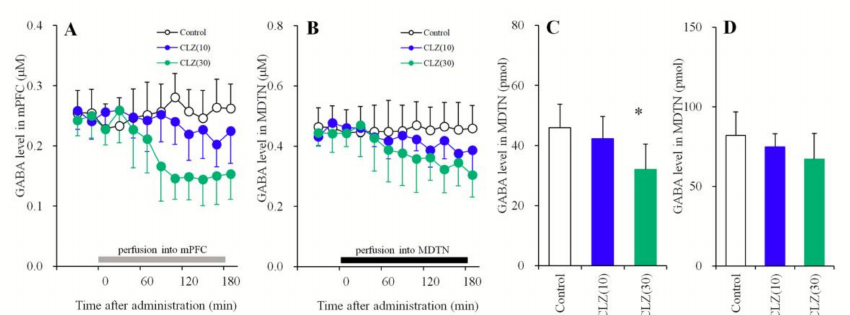
Figure 4. Concentration-dependent effects of the local administration (perfusion) of CLZ into the mPFC on extracellular GABA levels in the mPFC ( A , C ) and the perfusion of CLZ into the MDTN on levels in the MDTN ( B , D ). The perfusion medium commenced with MRS. After confirming the stabilization of extracellular GABA levels, the perfusate in the mPFC (A: gray column) or MDTN (B: black column) was switched to MRS containing CLZ (10 or 30 µ M) for 180 min. Ordinates: mean ± SD ( n = 6) of extracellular GABA levels ( µ M). Abscissas: time after administration of CLZ perfusion (min). AUC values of GABA levels (pmol) during perfusion with CLZ (from 20 to 180 min) based on ( A , B ) were indicated in ( C , D ), respectively. * p < 0.05. This is relative to the control (opened bar) using LME with Tukey’s post hoc test.